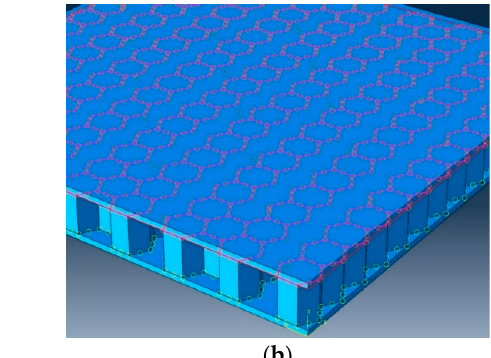
Figure 5. Air blast pressure–time response.